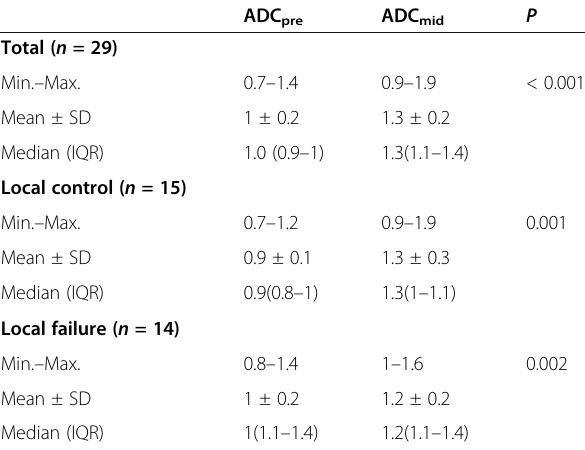
Local Local control